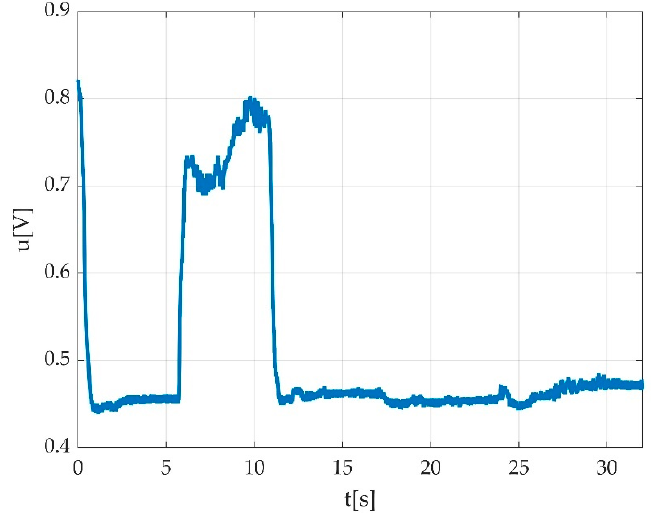
Figure 16. Example of an invalid measurement due to insufficient number of requested MVICs.